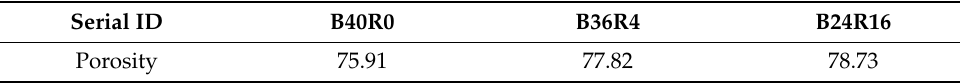
Figure 5. SEM image at 50 × and binary image of B40R0, B36R4, and B24R16 specimens. Table 7. Porosity of B40R0, B36R4, and B24R16 specimens.